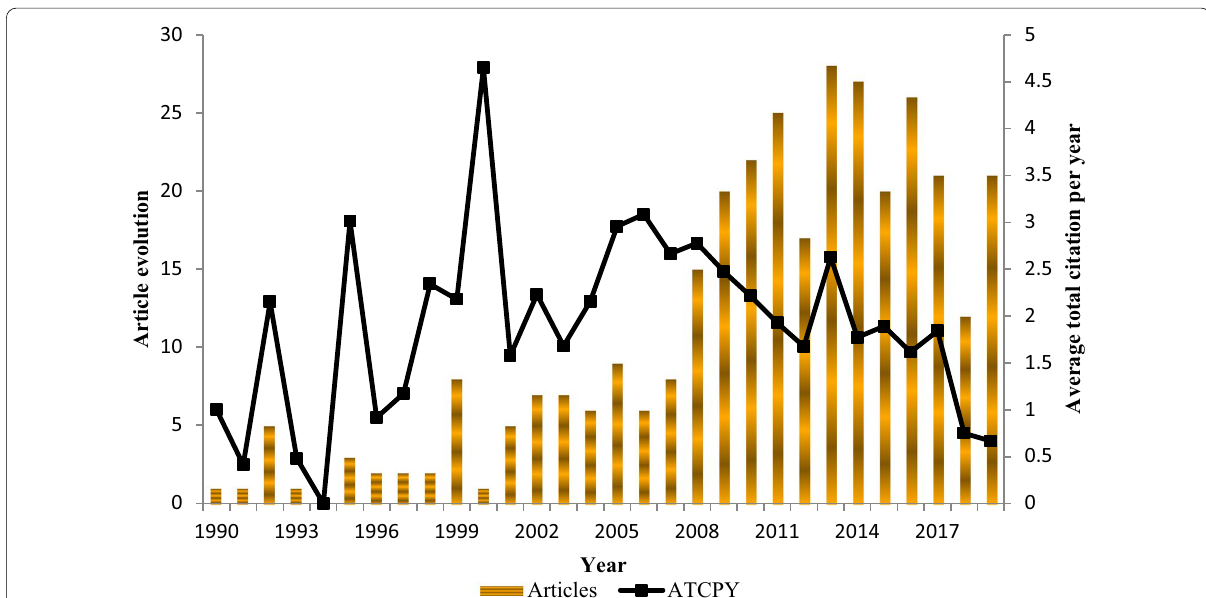
Fig. 1 Keratinase research articles published between 1990 and 2019. The article productivity is shown in bar graph; while line graph represents the average total citation per year